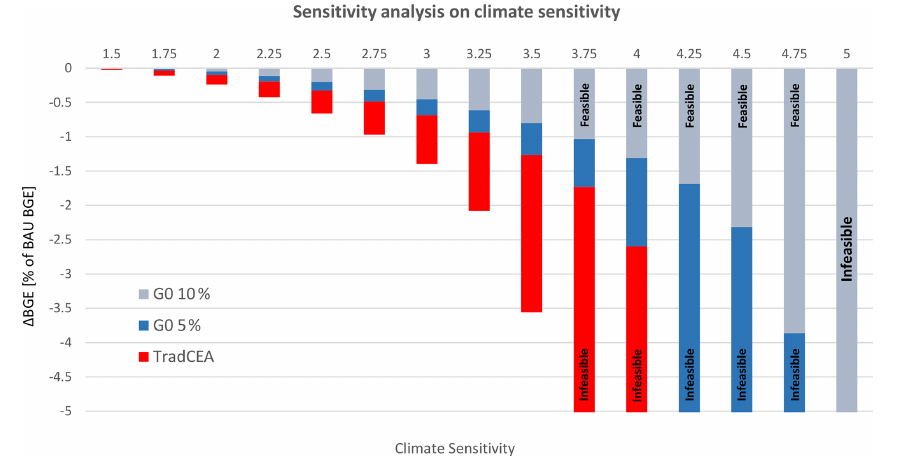
Figure 9. Sensitivity analysis on climate sensitivity. The gray bars show the BGE losses for the G0 10% scenarios. The blue bars show the BGE losses for the G0 5% scenarios. The red bars show the BGE losses for the TradCEA scenarios. For all scenarios, the climate sensitivity ranges from 1.5 to 5 ◦